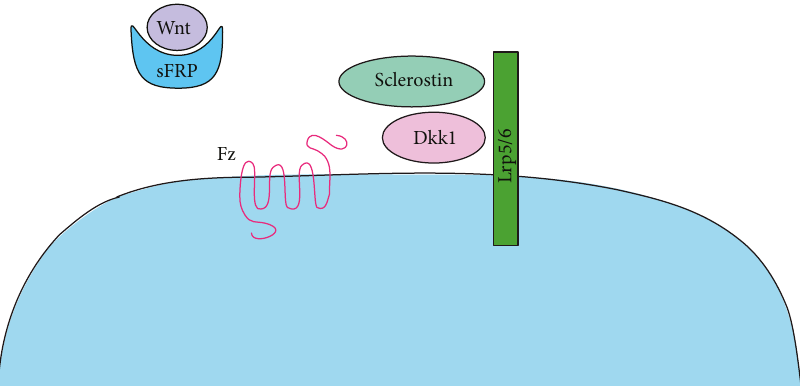
Figure 4: Mechanisms of action of common Wnt inhibitors. Sclerostin (light green) and Dkk1 (light pink) both prevent Wnt/ β -catenin pathway activation by binding to Lrp5/6, which prevents its interaction with Frizzled (Fz). The primary mechanism of action of SFRPs (blue) is to bind to Wnt molecules thus preventing its interaction with its receptor and further activate the Wnt/ β -catenin